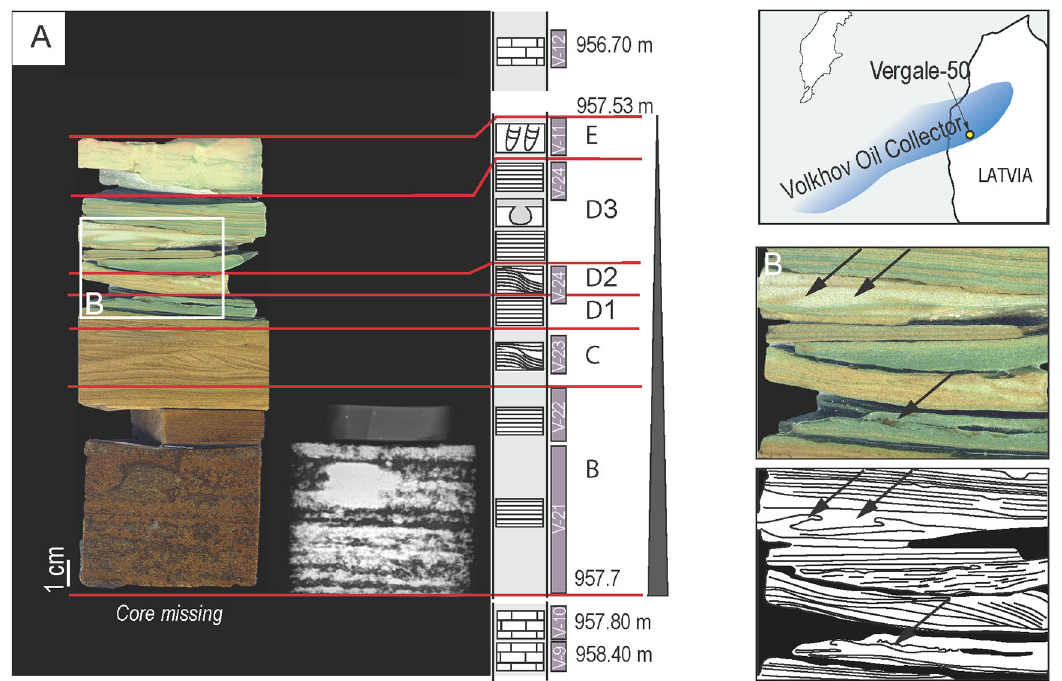
Fig. 4. The Volkhov Oil Collector in the Vergale-50 drill core. A , a colour photograph (left) and X-ray radiograph (right) of the lower part of the collector bed. Changes in sedimentary features and lithological patterns are indicated by red horizontal lines. Locations of grain size analysis samples are shown by numbered boxes. Identified units are marked with capital letters B to E. The general grain-size trend is shown by a vertical grey arrow. Lighter shades indicate denser materials and vice versa on X-ray radiographs. B , close-up and line-drawing of small sedimentary features in the upper part of the collector bed. Soft-sediment deformation features (load casts, flame structures) are indicated by black arrows. For legend see Fig.